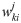
A voter and the voter ensemble network (NC = 4).(Left) A voter and the predefined firing probabilities of each voter neuron for a set of virtual input samples X = {x1, x2, …, xM}. (Right) The voter ensemble network. The weight wkij represents the weight of connection from the ith neuron of the jth voter to the kth neuron of the final voter.